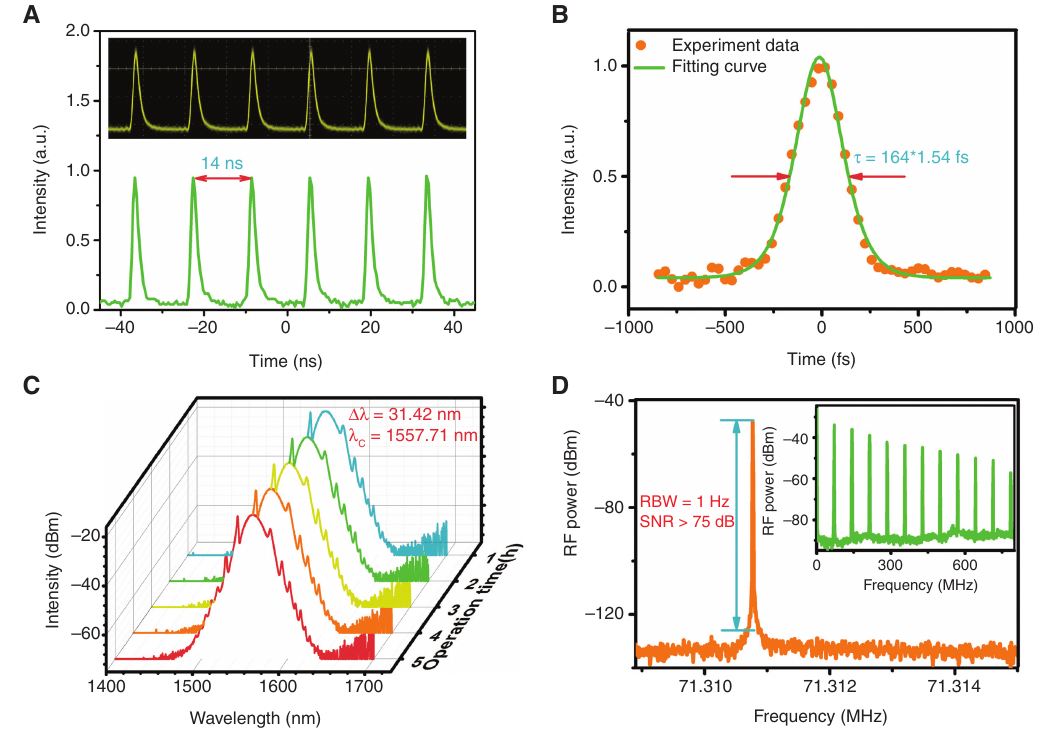
Figure 3: The operating parameters of achieved laser. (A) Oscilloscope signals; (B) Pulse duration; (C) Spectrum; (D) Radio frequency (RF)